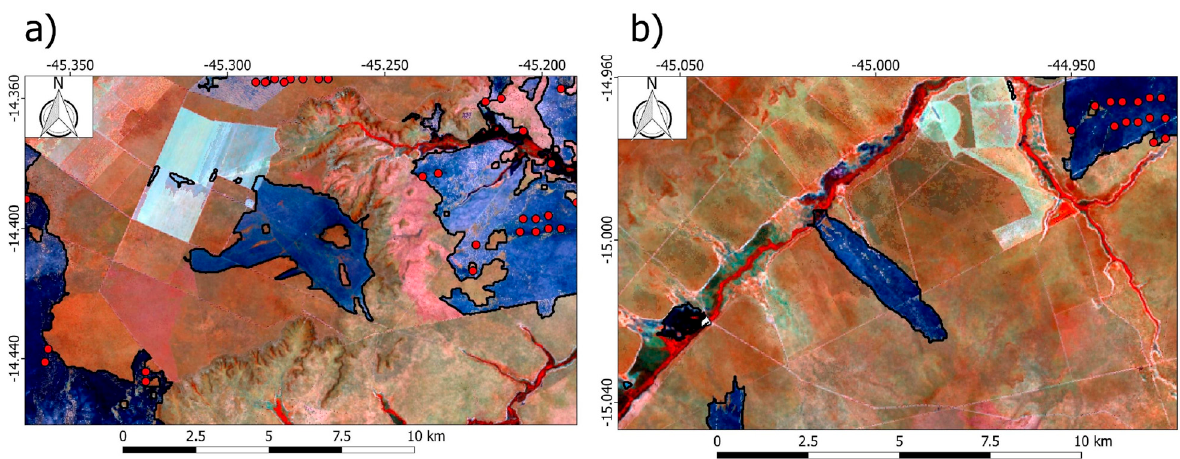
Figure 6. Burn scars (in blue) classified by AQM-LS algorithm in the presence of active fires (AF, respectively in red), highlighting two cases where burn scars were classified in the absence of AF: ( a ) burn scar with 852 ha and ( b ) burn scar with 368 ha. RGB 567 image composite from 6 August to 12 December 2015 for the 219/070 scene.